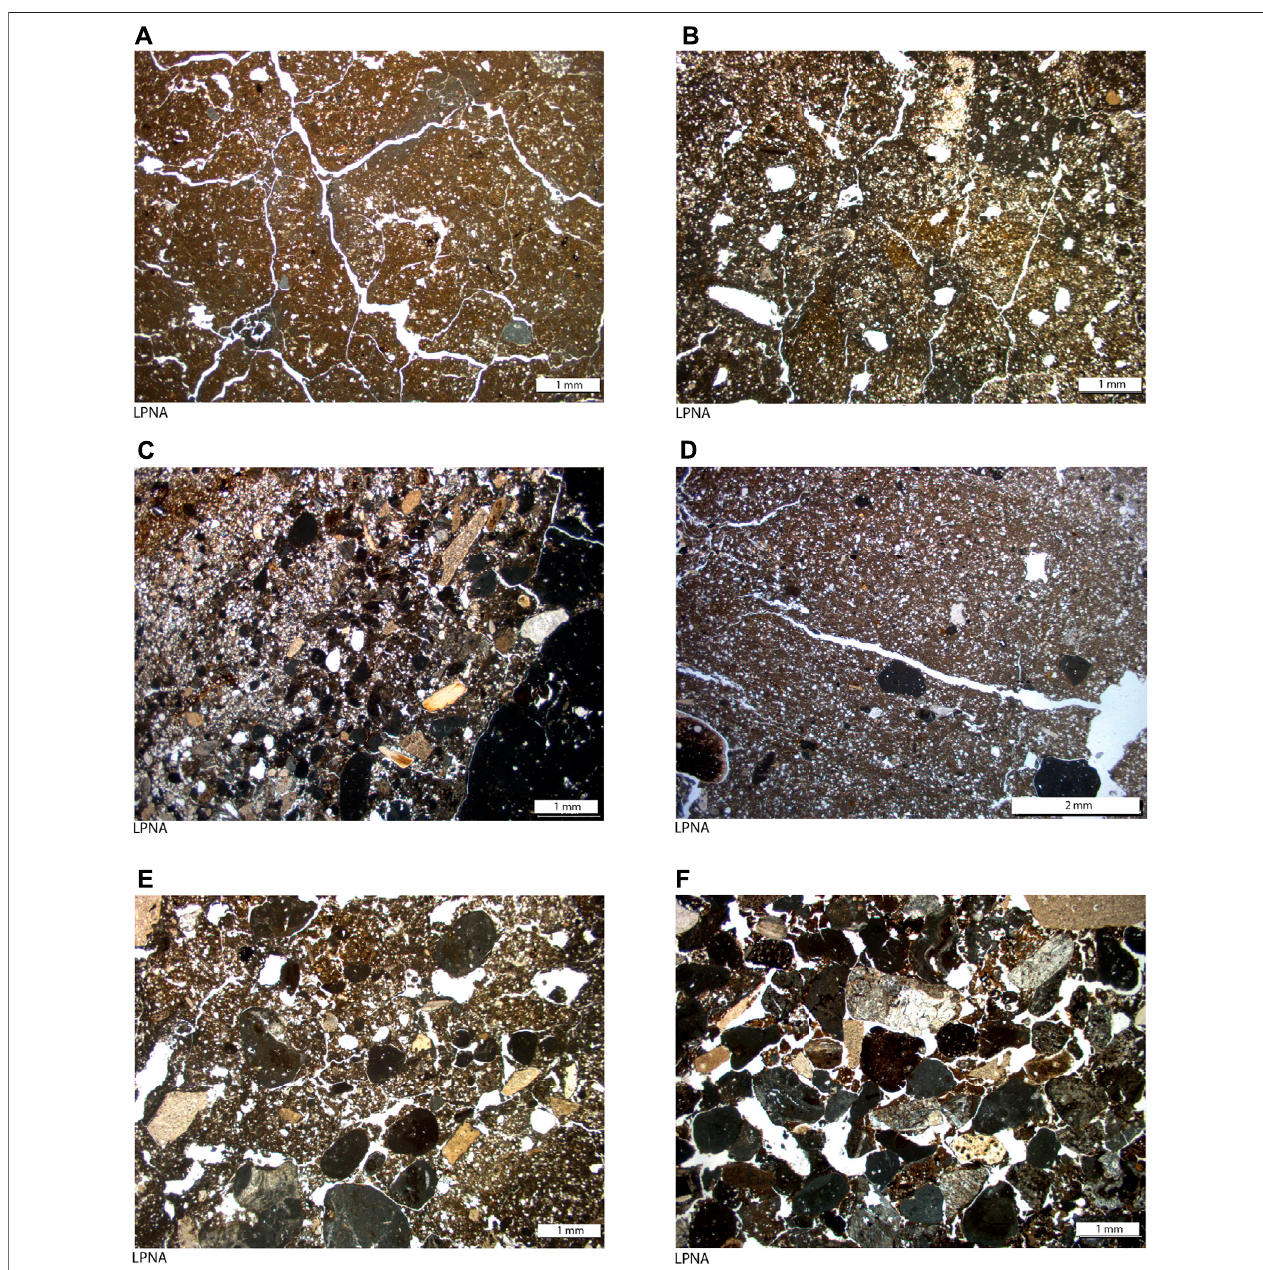
FIGURE 6 | Sedimentary facies including (A) clayey silty microfacies with a massive structure and subangular polyhedral blocks, separated by splits and deviated and interconnected cracks typical ofthe shrinking – swelling phenomenon (sample KH 1B, layer I); (B) amicrostructurewithsubangular polyhedral blocks superimposed onamicrostructurewithchannelsinvokingarootletbiologicalactivity(sampleKH3B,layerIII); (C) microfacieswithbeddedmicrostrataofcoarseand fi nesands(sample KH 12H, layer X); (D) microfacies withcompactsilty – clayey – sandy lenses superimposed on silty – sandy lenses with aplatymicrostructure (sample KH 7B,layer V); (E) microfacies with unorganized and heterogeneous coarse particles with grain and micro-aggregate packing, plane voids, and porphyric distribution (sample KH 2H, layer II) and (F) with chitonic distribution (sample KH 12H, layer X).